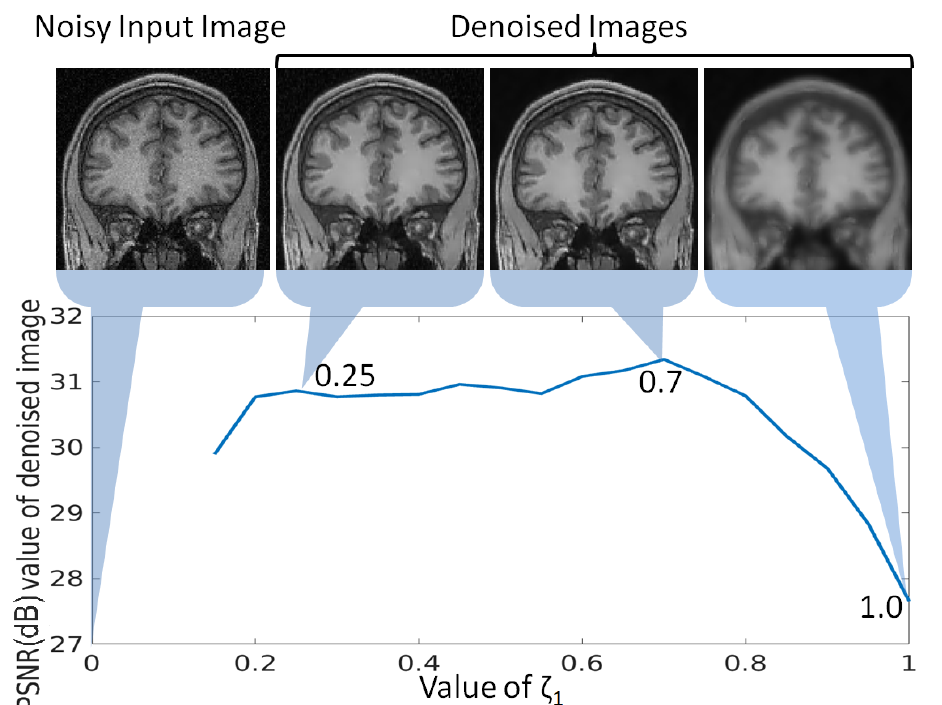
e i , e i denotes the low rank- i = 1